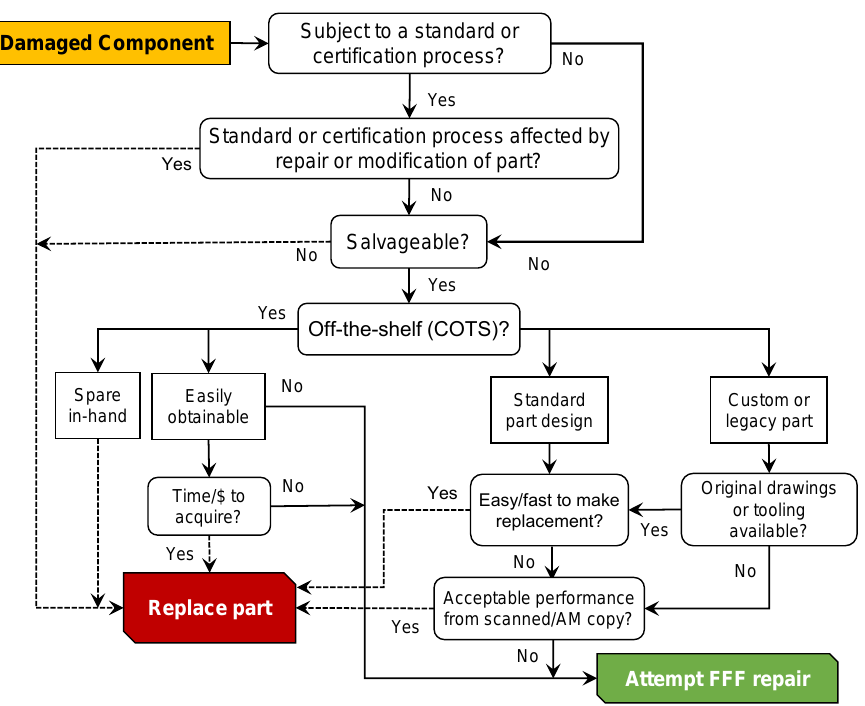
Figure 5. Decision-making process to establish potential FFF repair